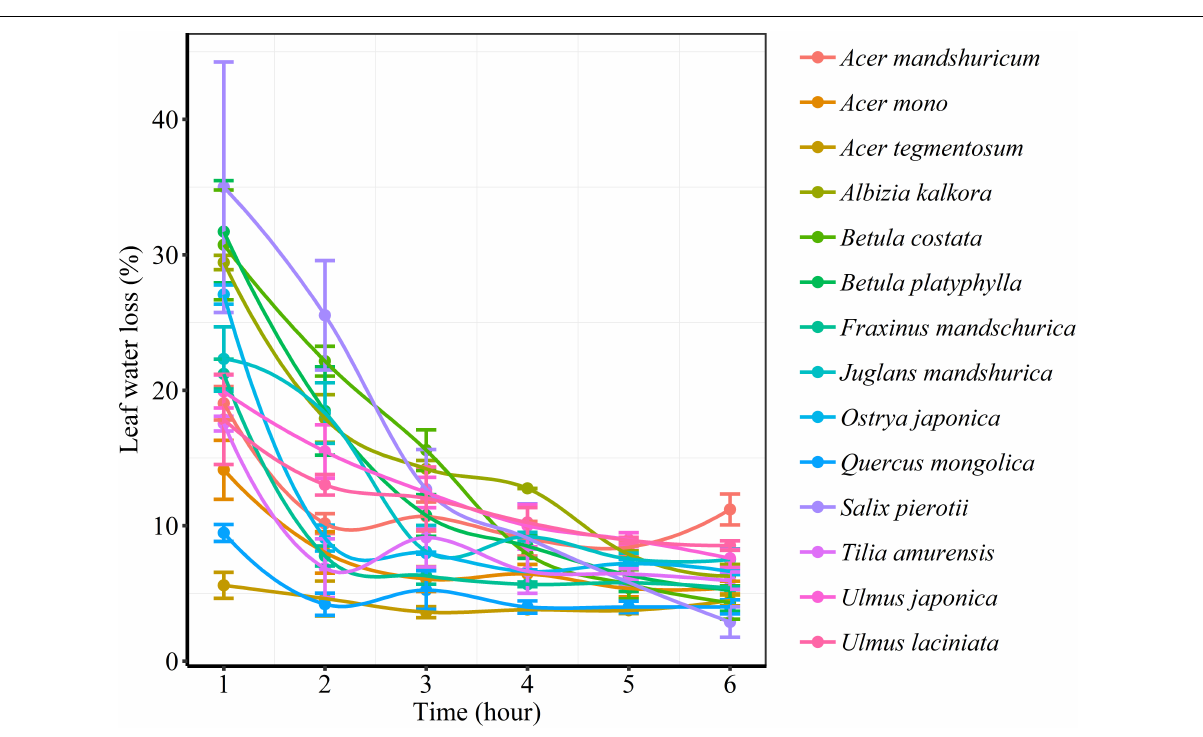
FIGURE 3 | Changes in leaf water loss (%) of different tree species over